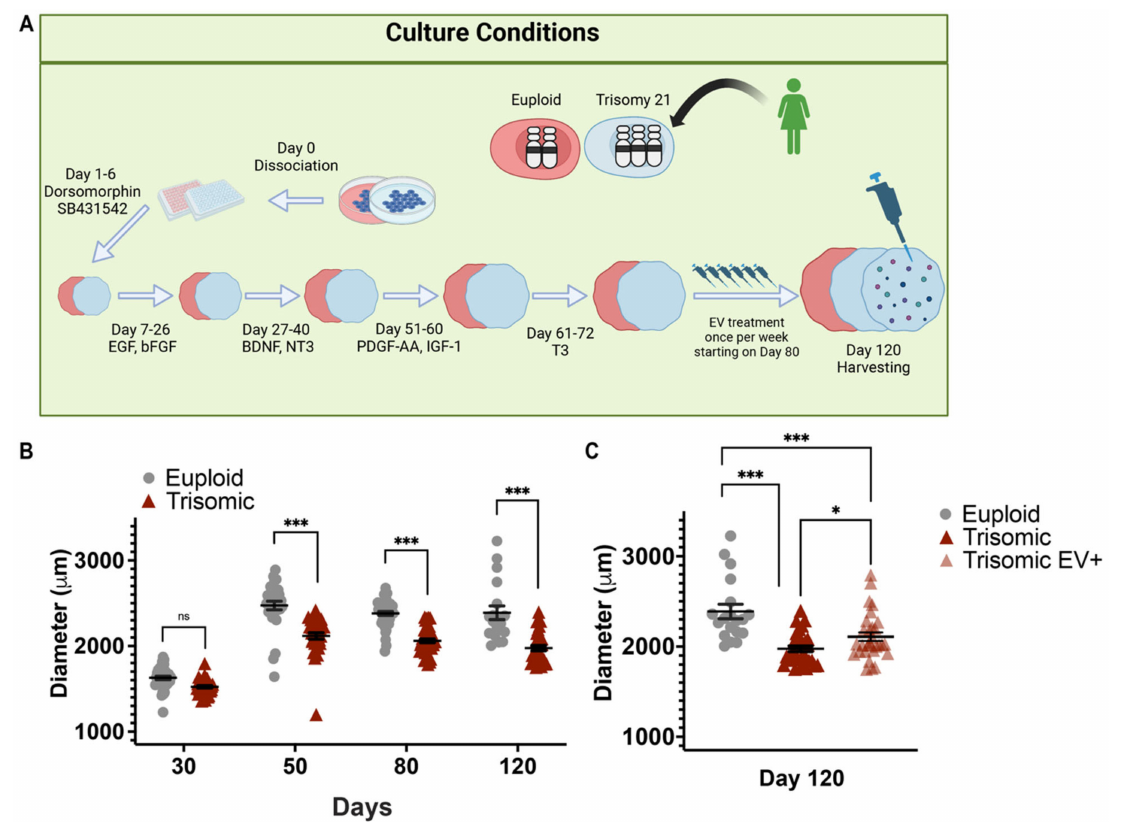
Figure 1. EV treatment preserved the size of trisomic CS. ( A ) Schematic representation of CS develop- ment protocol and experimental design demonstrating differentiation of iPSCs into CS. Created with BioRender.com (accessed on 14 November 2022). ( B ) Vertical scatter plot showing individual data (closed gray circles and red triangles) and mean +/ − SEM (black lines) of measured diameters ( µ m) of euploid and trisomic CS generated from isogenic cell lines on days 30 (euploid n = 38; trisomic n = 37), 50 (euploid n = 31; trisomic n = 35), and 80 (euploid n = 45; trisomic n = 44). ( C ) CS from day 120 showing euploid (n = 38) and trisomic groups with or without EV treatment (trisomic n = 73; trisomic EV+ n = 75). The graphs show the results obtained from the data collected from three independent experiments. Statistical analysis was performed by one-way ANOVA comparing each group’s mean. Results are shown as mean ± SE.* p < 0.05, *** p < 0.001, ns =